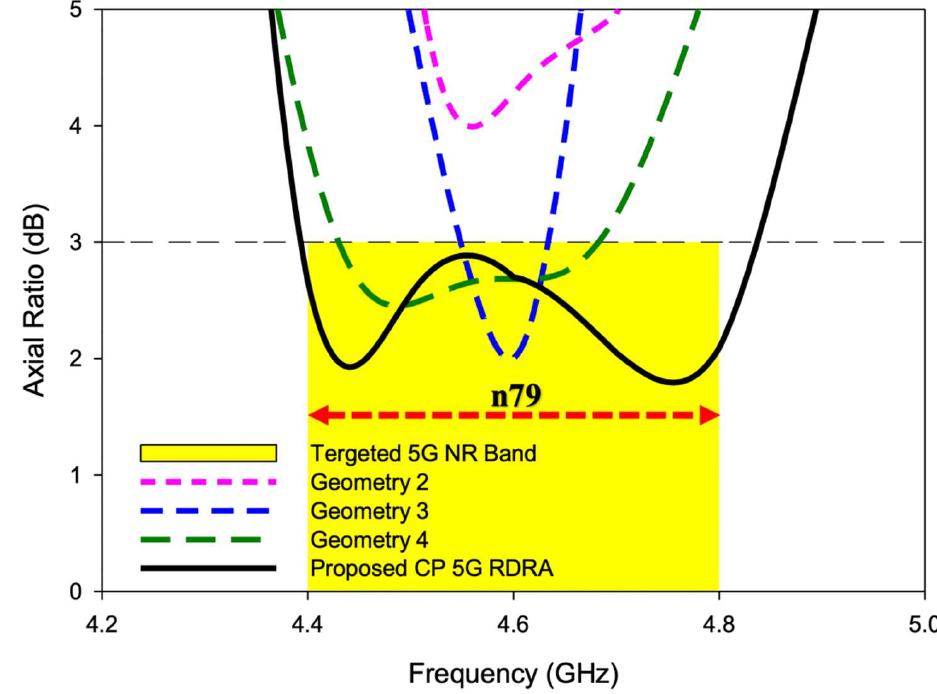
Figure 4. Axial ratios comparison of different geometries toward the development of the CP 5G RDRA.